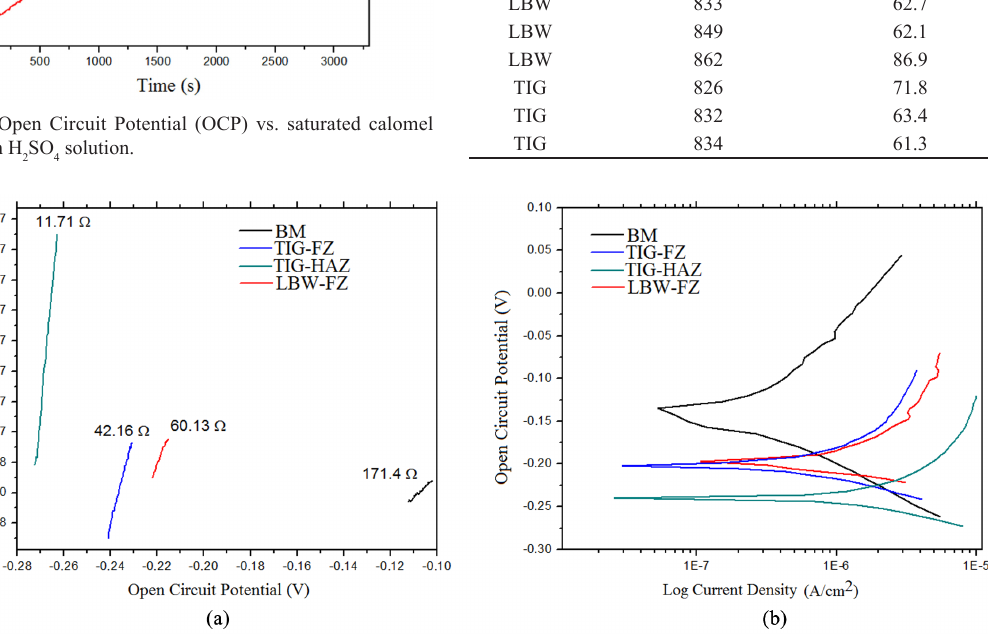
SO solution. 2 4